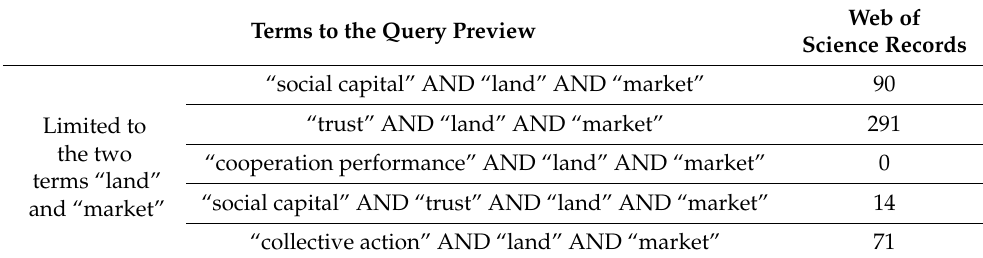
Table A1. Correlation table between social capital and trust (Until 17